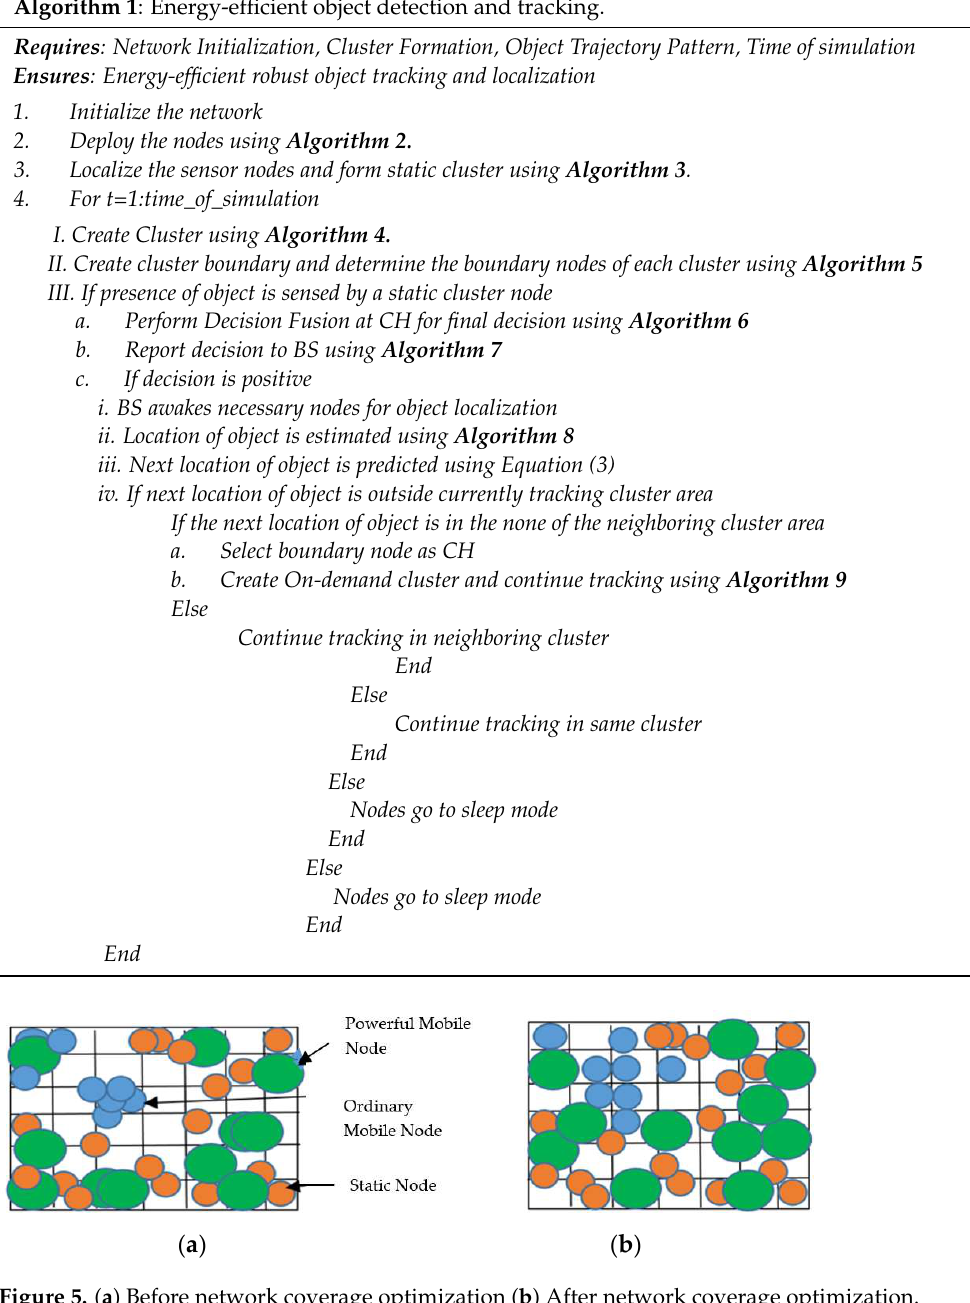
Algorithm 1 : Energy-efficient object detection and tracking.